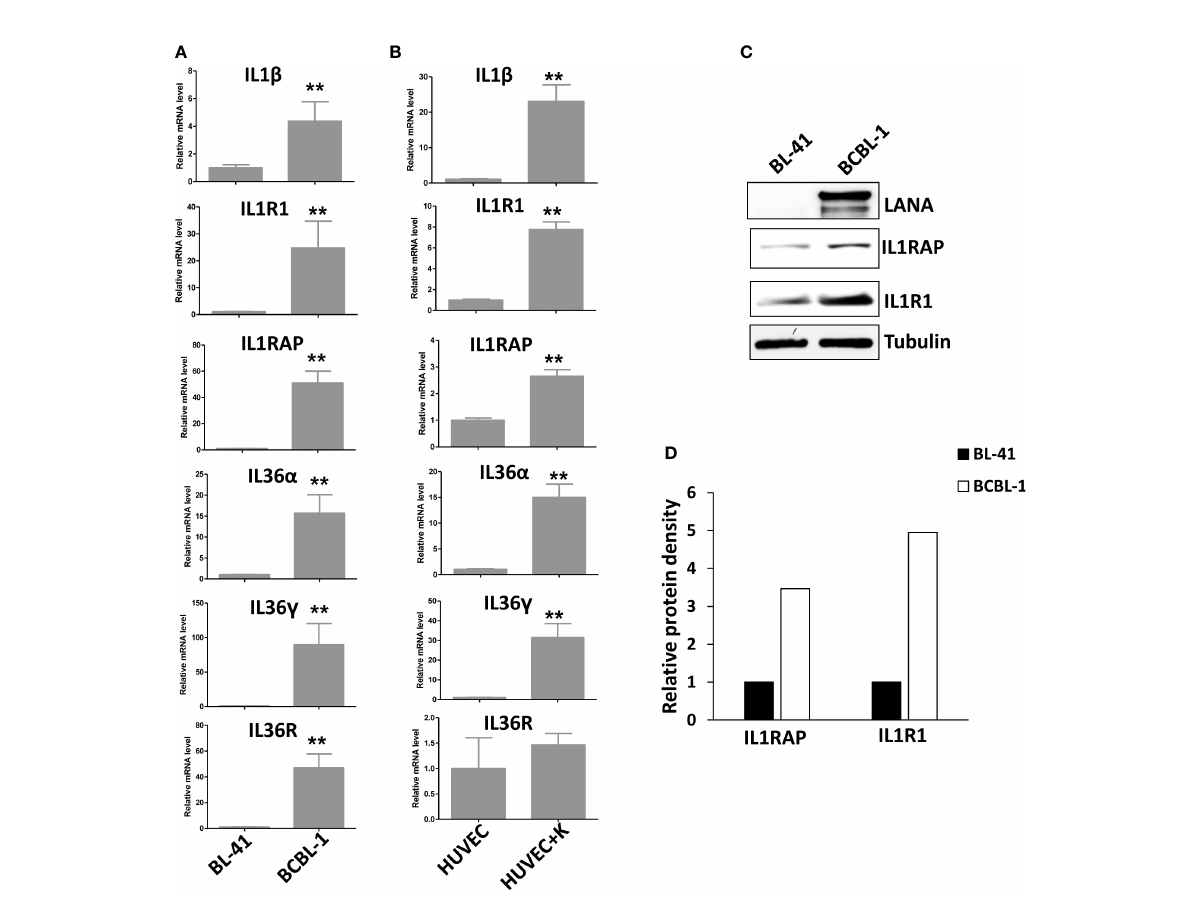
FIGURE 1 Activation of IL1 signaling in KSHV-infected PEL and primary endothelial cells. (A) Gene expression was detected and compared between BL-41 (a KSHV negative lymphoma cell line) and BCBL-1 (a KSHV+ PEL cell line) by using RT-qPCR. (B) Primary endothelial cells HUVEC were infected with KSHV (MOI~5) or not for 48 h, followed by RT-qPCR analysis. Error bars represent the S.D. for 3 independent experiments. **p<0.01. (C, D) The protein expression was measured using Western blot, and representative blots from one of two independent experiments were shown. The density of protein bands was scanned and quanti fi ed using Image J